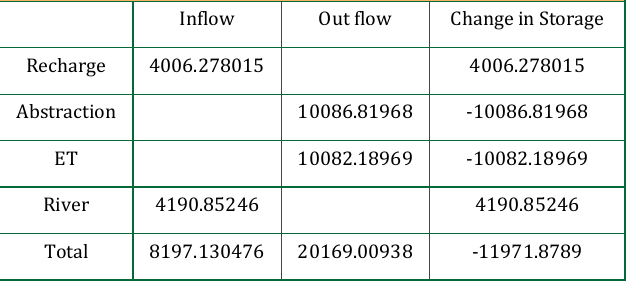
Table 8: Annual GW abstractions decreased 20% with increased the Canal Supply (MCM)